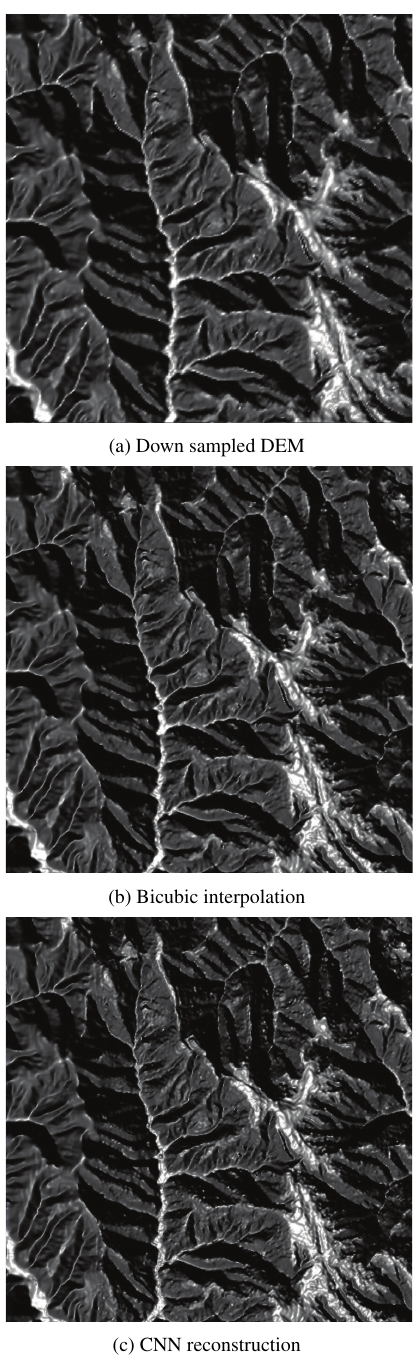
Figure 3. Bicubic interpoation and CNN reconstruction of a mountain